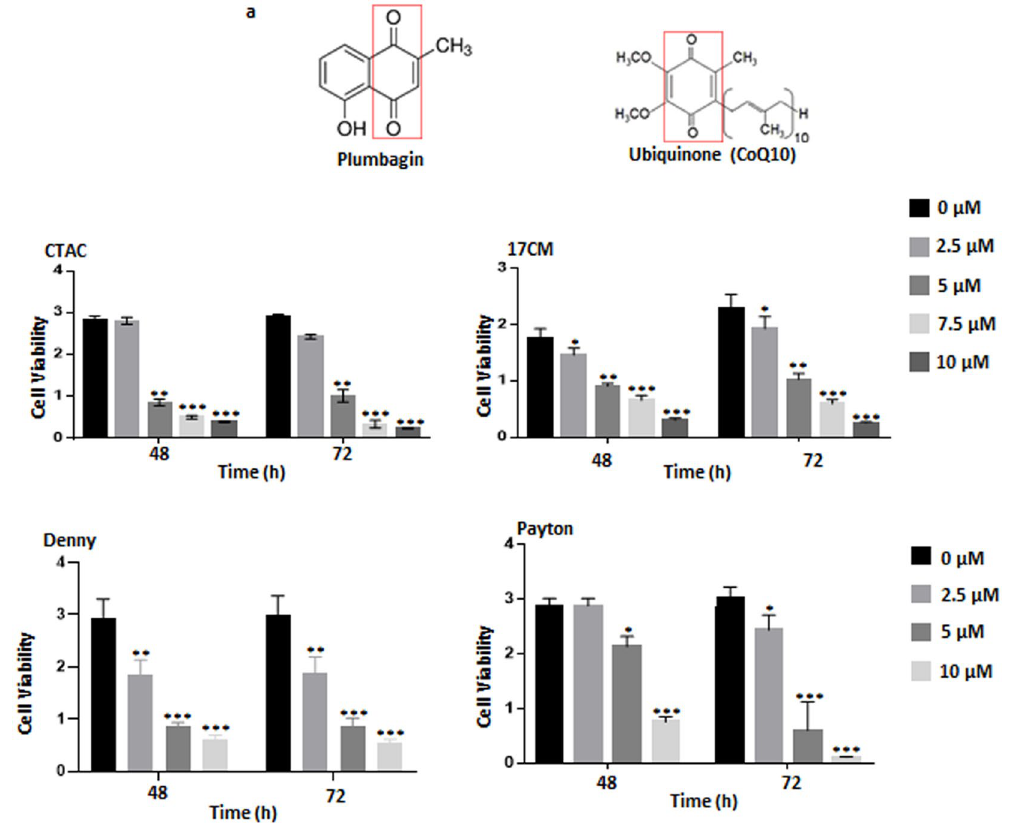
Figure 1. Plumbagin inhibits the proliferation of canine cancer cells. ( a ) Structural similarities between plumbagin and ubiquinone are indicated by the red box. ( b ) The canine cancer cell lines (CTAC, 17CM, Denny and Peyton) were treated with plumbagin (0–10 μ M) for 48 and 72 hours and proliferation of the cell lines was determined using MTT assay. The average of eight wells was used to plot the bar graphs for each condition tested. Data shown is representative of three independent biological replicates. * p = 0.013, ** p = 0.003, and *** p = 0.0002 of test versus controls for each time